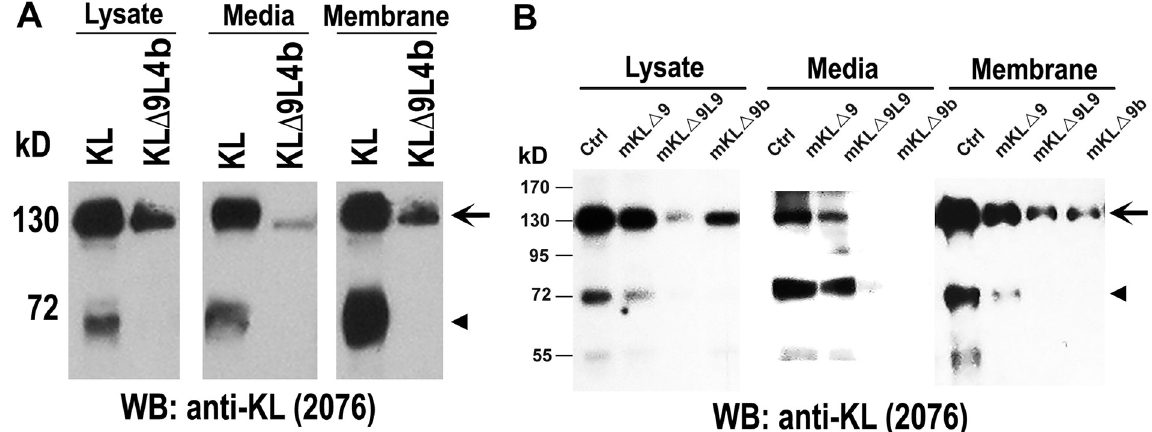
Fig 2. Determination of potential shedding sites in Klotho. A) Western Blot of indicated human Klotho plasmids transfected in COS-7 cells. Protein samples were collected from either cell lysates, media or after cell-surface biotinylation assay (membrane proteins). Arrow indicates that the KL Δ 9L4b 70 kD band is lost compared to KL-WT. B) Western Blot of indicated mouse Klotho plasmids transfected in HEK cells. Protein samples were collected from either cell lysates, media or after cell-surface biotinylation assay (membrane proteins). Arrow indicates the 130 kD protein and arrowhead the 70 kD Klotho